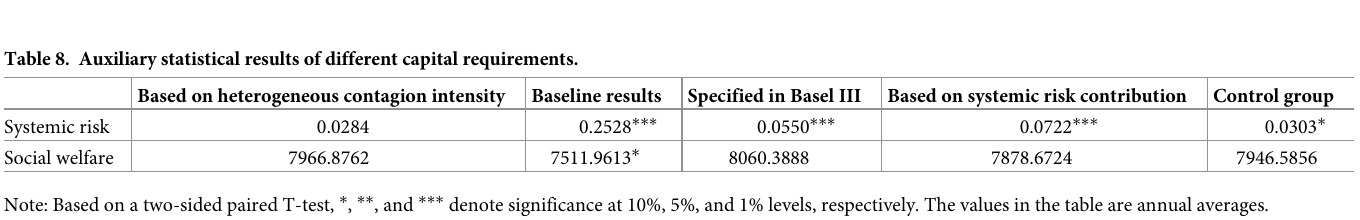
Fig 16. Effectiveness analysis of pairwise capital requirements. The systemic risk and market surplus in the figure are normalized by dividing by the level of baseline results.